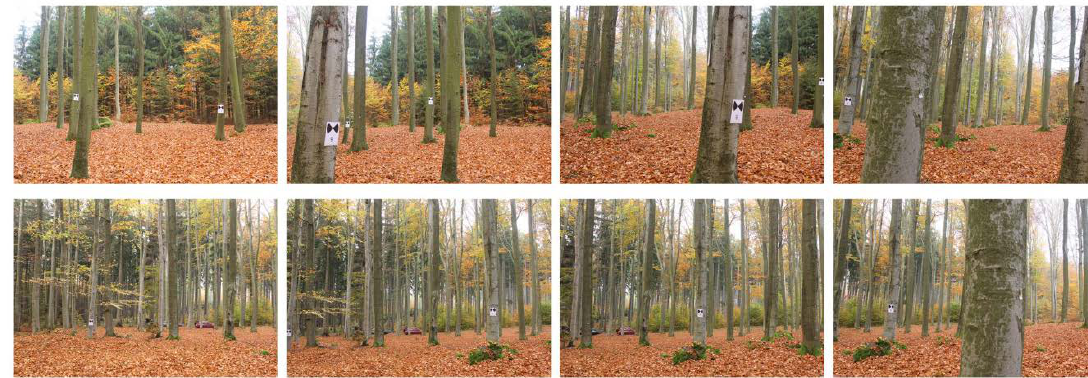
Figure 9. Sub-optimal image sequence for successful automatic image orientation.